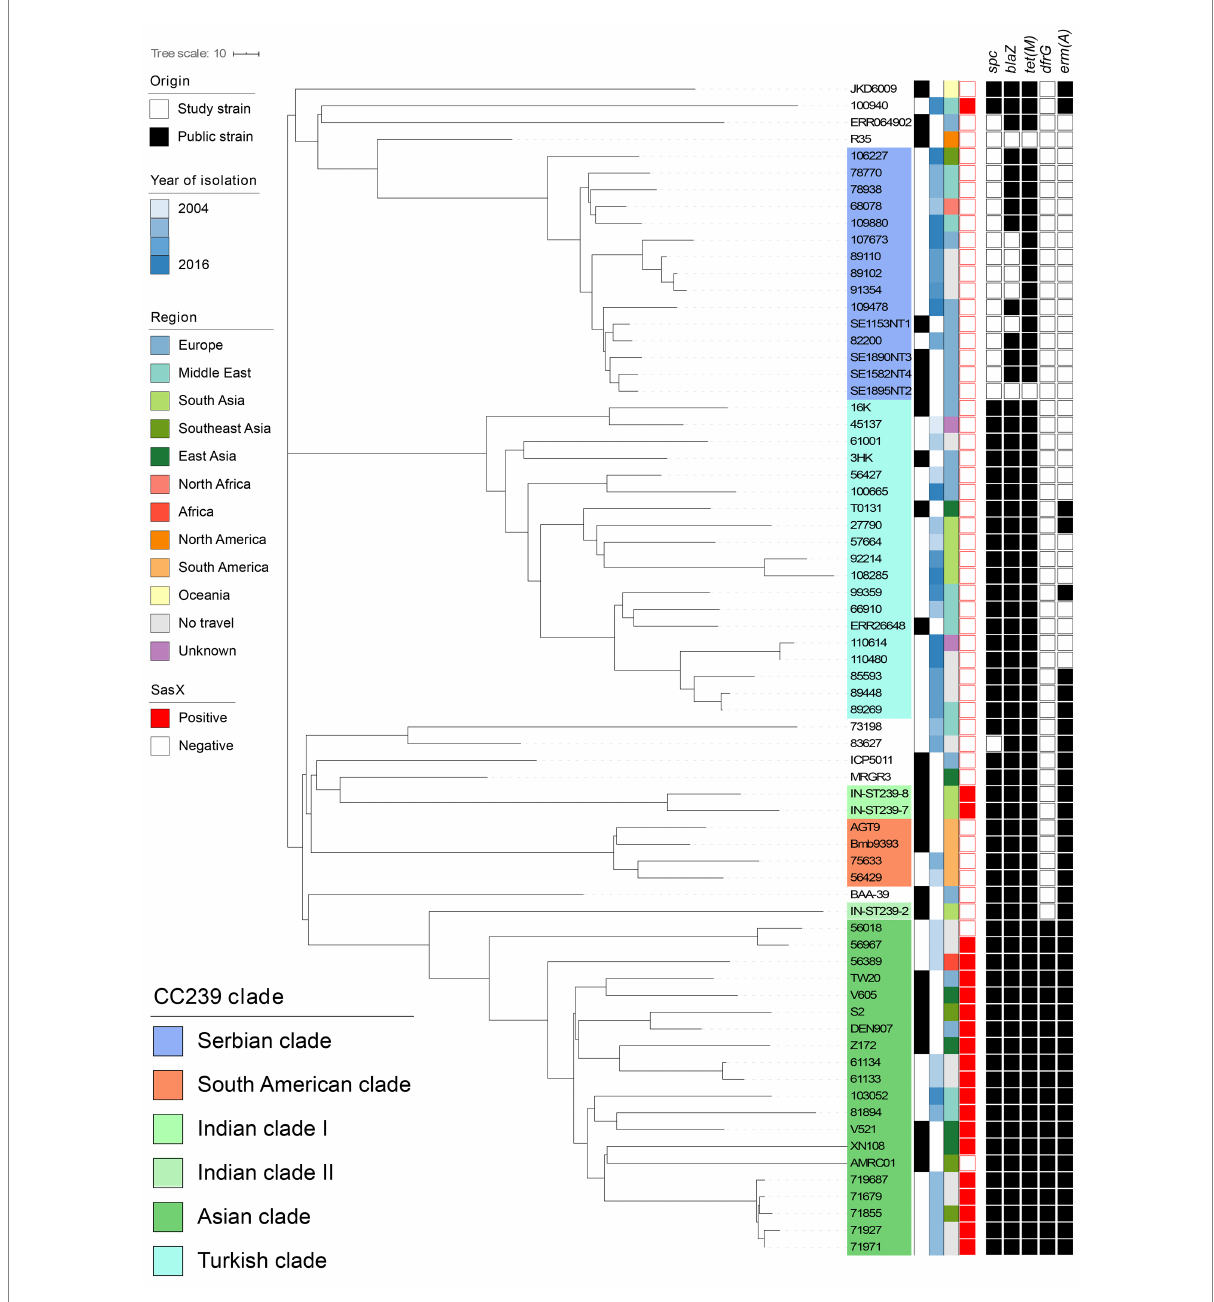
FIGURE 2 Core-genome phylogeny of all MRSA ST239 isolates isolated from Denmark ( n = 40) and published context sequences ( n = 27). Clustering is done in line with Harris et al. (2010) and De Backer et al. (2019) clades are indicated by colored overlays. Metadata is visualized in the lanes in compliance to the legend, from left to right: (i) Origin of the isolate; (ii) Year of isolation; (iii) Region of travel; (iv) sasX carriage; and (v) Carriage of antimicrobial resistance genes spc , blaZ , tet(M) , dfrG , and erm(A) with black signifying carriage and white non-carriage. The context sequences were downloaded from Genbank and Sanger Institute. Branch lengths represent the substitution rate per position in the core-genome alignment as indicated in the scale bar. The tree is publicly available on MicroReact